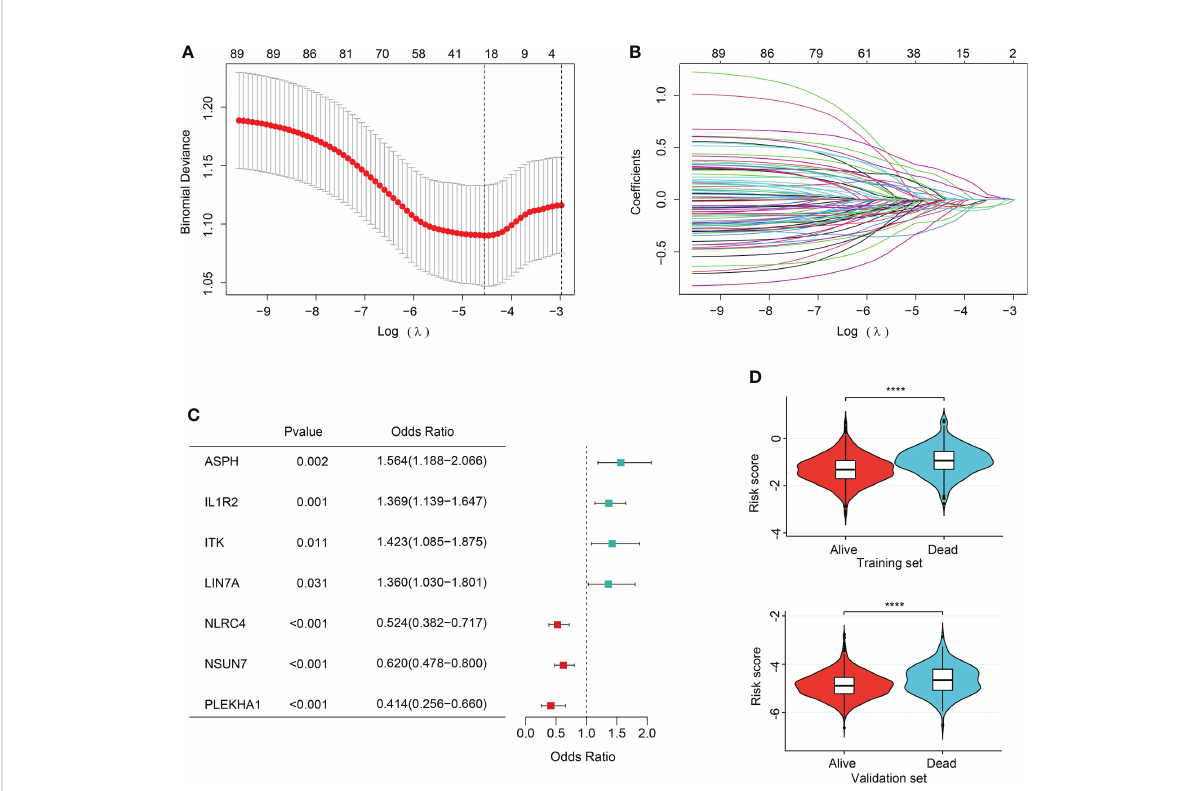
FIGURE 6 Feature selection and association of risk score with sepsis outcomes. (A) The ten-fold cross-validation results. The line on the left indicated the value of the parameter log( l ) for the error-minimized model. 28 variables were fi ltered out when log( l ) = − 4.74. (B) LASSO coef fi cient pro fi les of the 28 features. (C) Forest plot of features signi fi cant in logistic regression analysis. (D) Violin plot of distribution of risk score between cluster A and cluster B in the training (upper) and validation (lower)